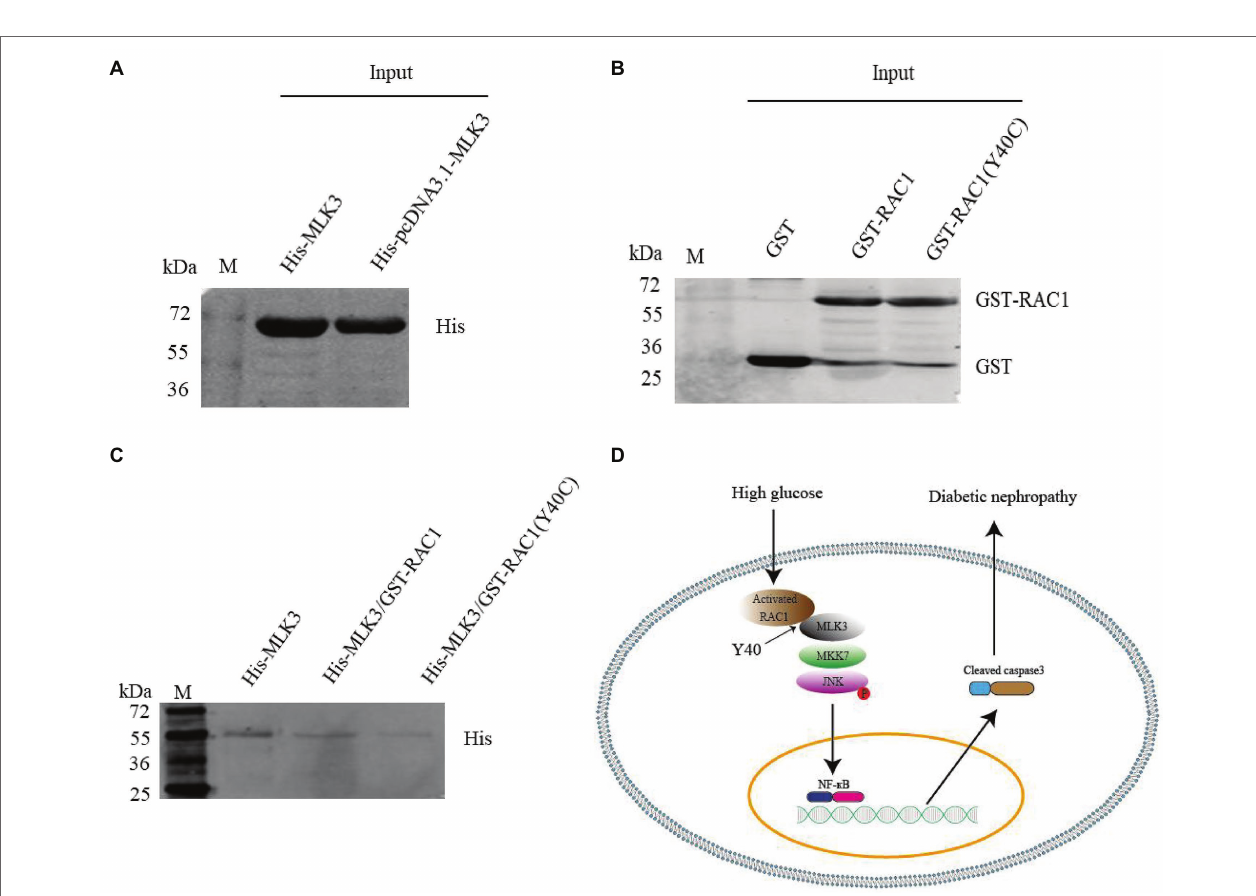
FIGURE 6 | pcDNA3.1-MLK3 as bait protein. (C) Colocalization of RAC1 and MLK3. RAC1 is marked in red, MLK3 is marked in green, the cellular nucleus is labeled in blue by DAPI, and the colocalization of RAC1 and MLK3 is presented in yellow. The scale bar is 10 μ m (magnification × 400).